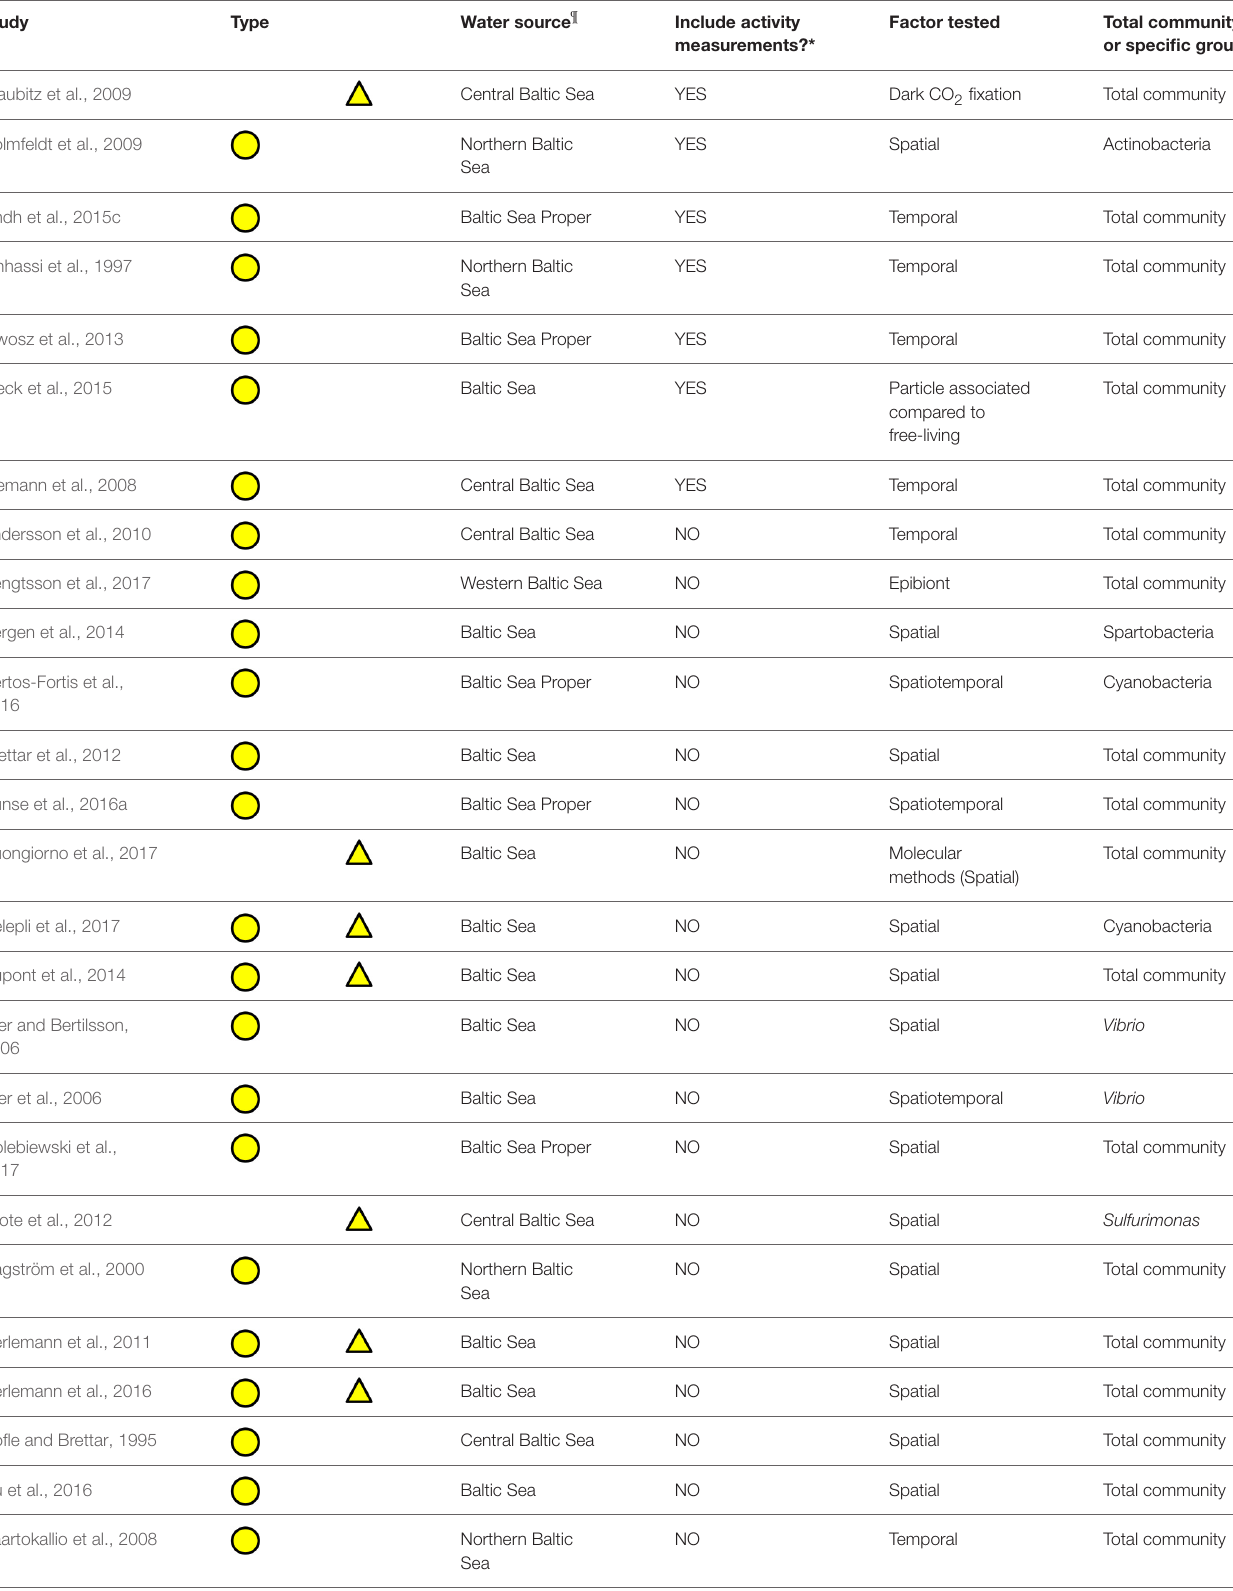
TABLE 1 | Summary of Baltic Sea bacterioplankton studies in which data on community composition is available ( n =